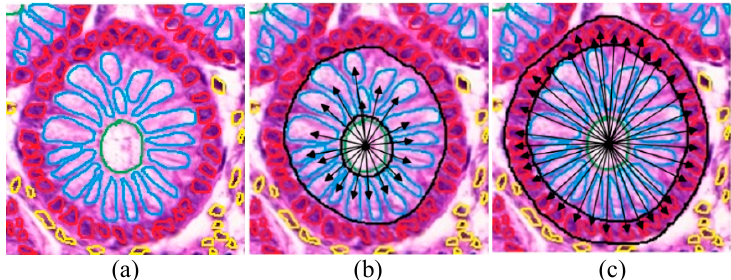
Figure 7 . ( a ) A single normal colon gland with demarcated lumen, epithelial cells and nuclei; area features are computed from epithelial cells, lumen and nuclei, ( b ) distance from the centroid of lumen to the centroid of each epithelial cell, ( c ) distance from the centroid of lumen to the centroid of each cell nucleus. Figure shows one glandular region cropped from an image captured at 20× magnification.